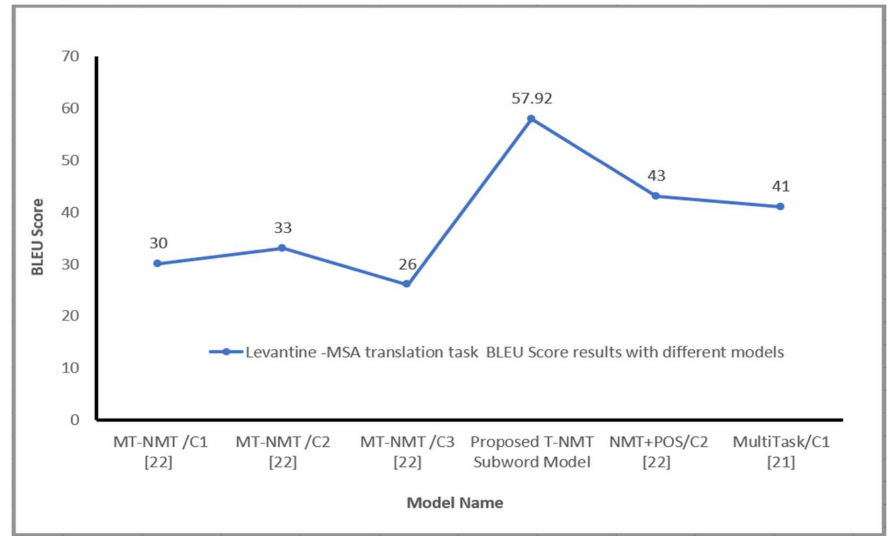
Figure 4. Levantine Arabic-MSA BLEU Score with different models, where C 1 is a random embed- ding, C 2 a pre-trained/Fast-text, C 3 a pre-trained/Polyglot.